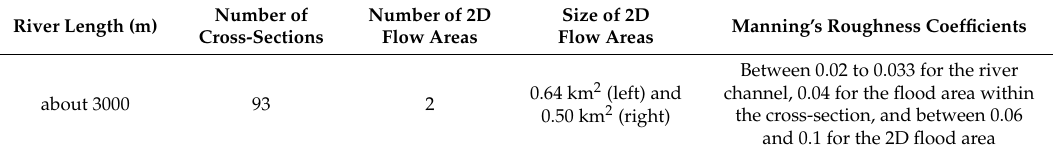
Table 2. Basic characteristics of the hydraulic model of the Glinšˇcica Stream catchment. 2D: two-dimensional.